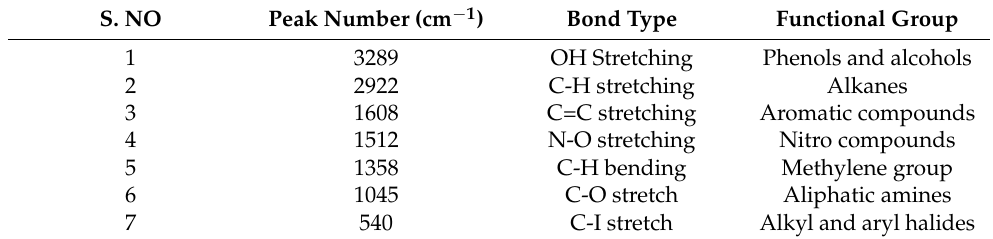
Alkyl and aryl halides